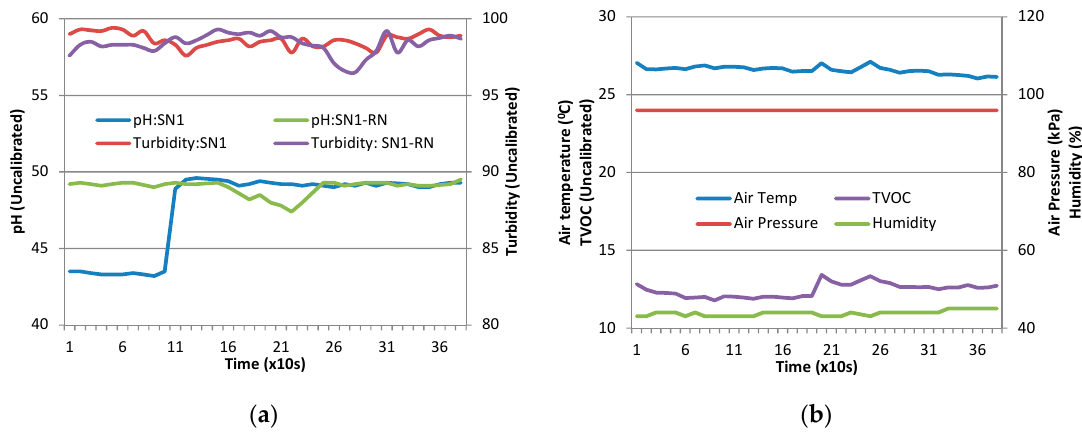
Figure 10. WQM parameters ( a ) pH and turbidity from two different SNs, ( b ) Temperature, humidity, pressure, and uncalibrated total volatile organic compound measure (TVOC) from different SNs.